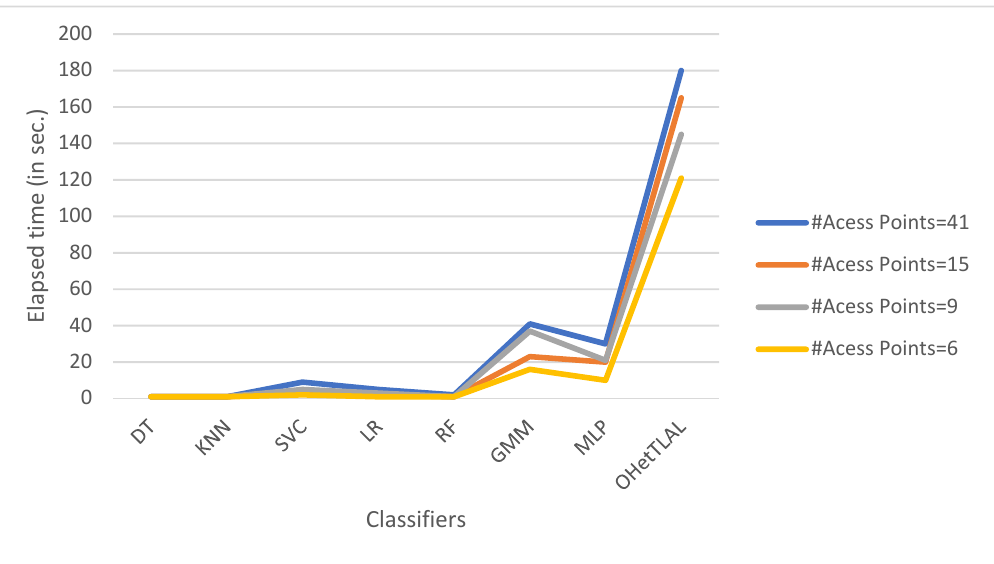
Figure 26. Comparative analysis of computational testing time of the algorithms used for FBIPS.